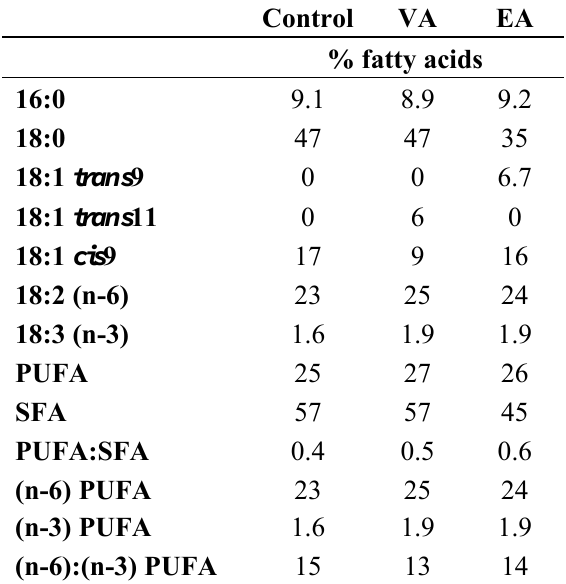
Table 6. Fatty acid composition of experimental diets.